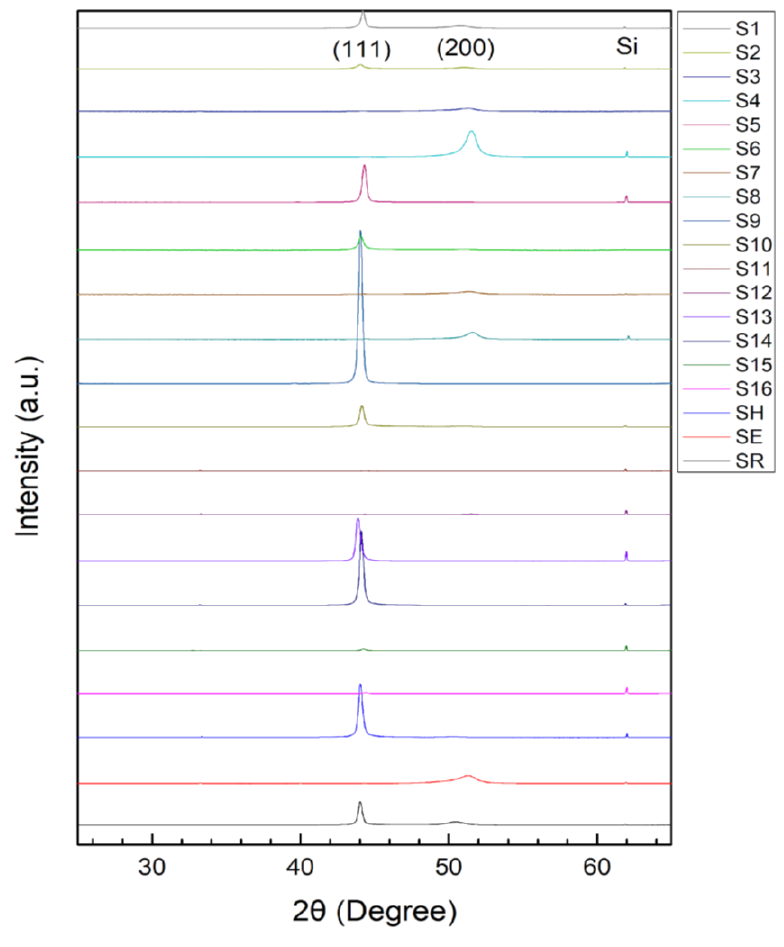
Figure 4. θ/2θ XRD patterns of each film.